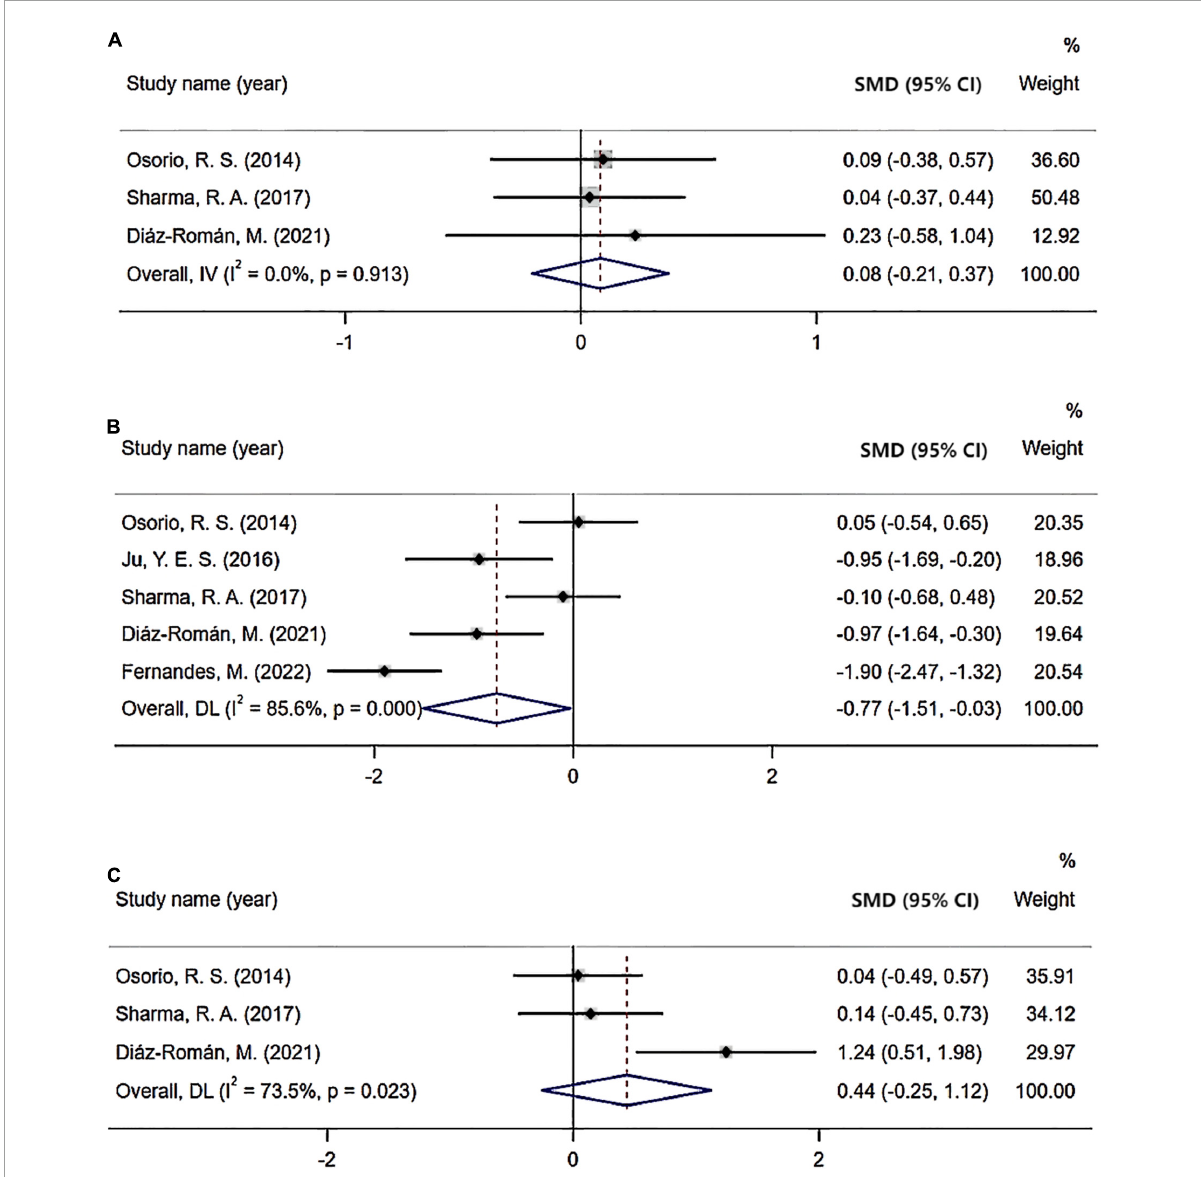
FIGURE5 Forest plot of cerebrospinal fluid (CSF) A β 42 level: (A) Mild obstructive sleep apnea (OSA) compared with healthy control; (B) Moderate/severe OSA compared with healthy control; (C) Mild OSA compared with moderate/severe